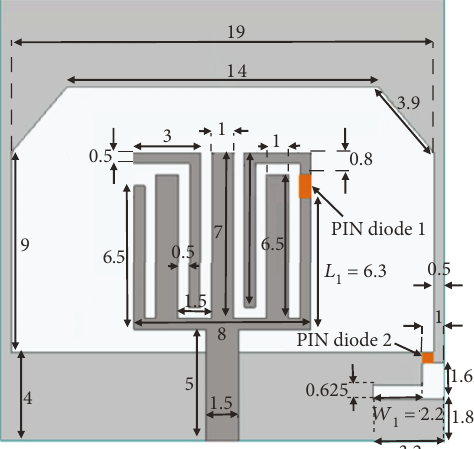
Figure 12: A microstrip slot antenna with the ability of recon fi gurable frequency along with switchable band notches for an ultra-wideband